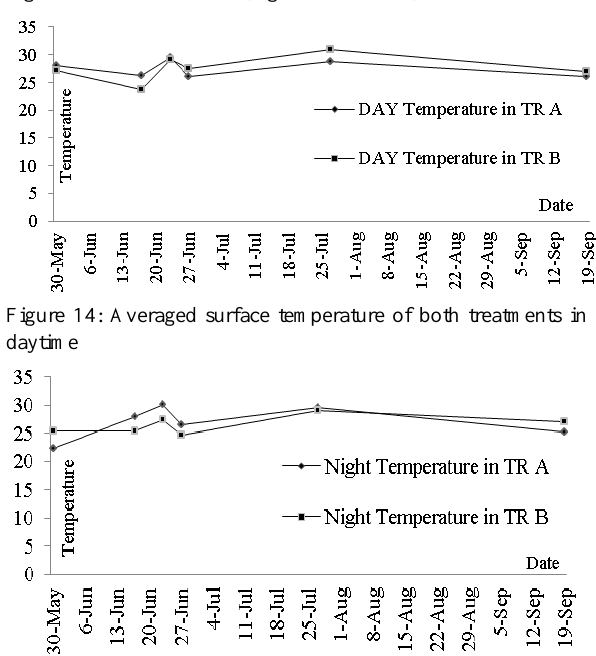
Figure 15: Averaged surface temperature of both treatments in nighttime As can be seen, in most cases the surface temperature of control sample was lower during the daytime and it was higher in nighttime. In fact the presence of industrial effluents causes a decrease in energy absorption of the test sample during the